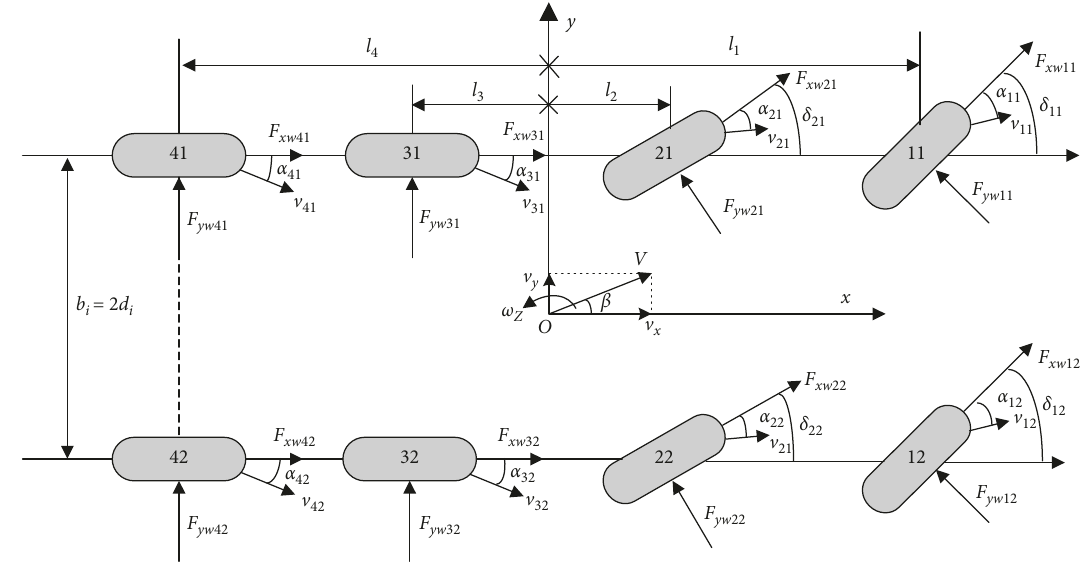
Figure 2: xoy planer motion of the 8WIDEV body.